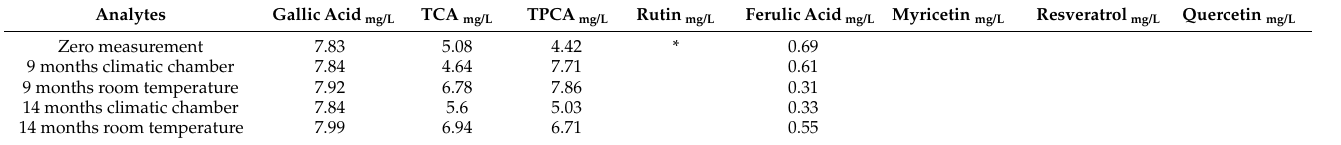
Table 12. Biologically active substances . Sample A—Sauvignon, wine harvest 2016. Analytes